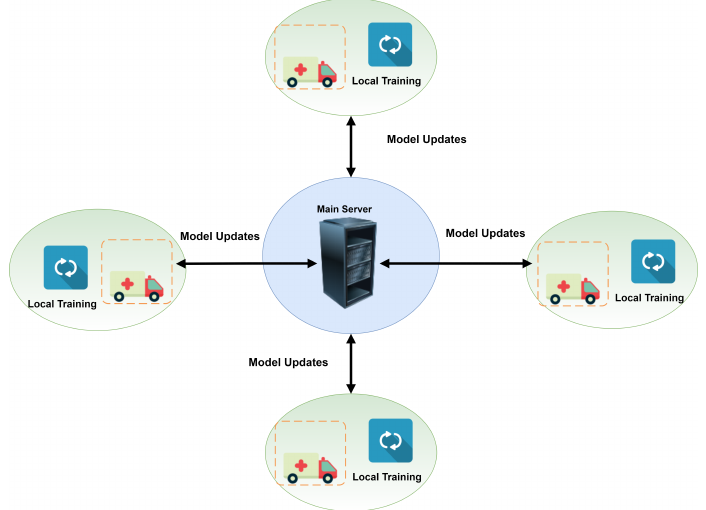
Figure 4. Usage of federated learning in a VANET